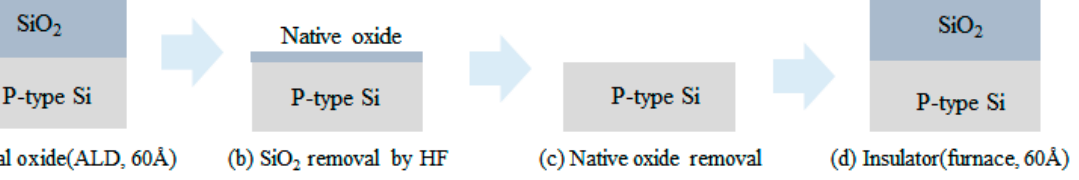
Figure 3. The structure of TFT process used in this study: ( a ) SiO 2 deposited by ALD on silicon ( b ) Removal of SiO 2 by HF cleaning ( c ) Native oxide removed by cleaning process ( d ) Gate oxide grown by vertical-type furnace on